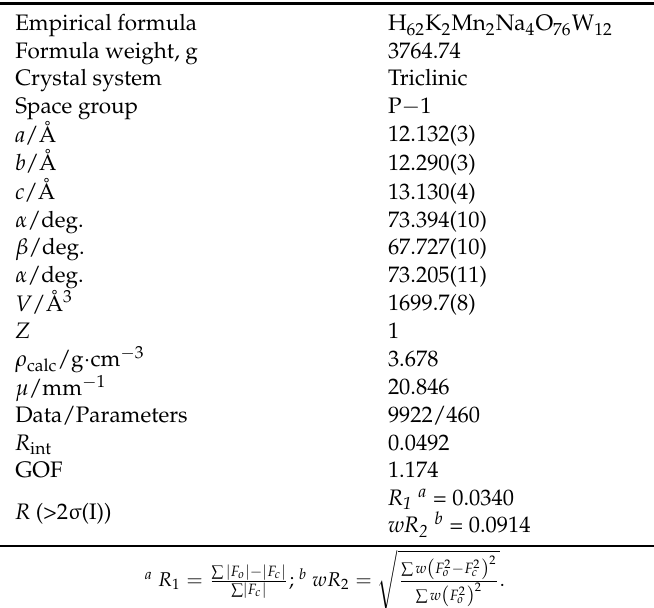
Table 3. Crystallographic data for 1